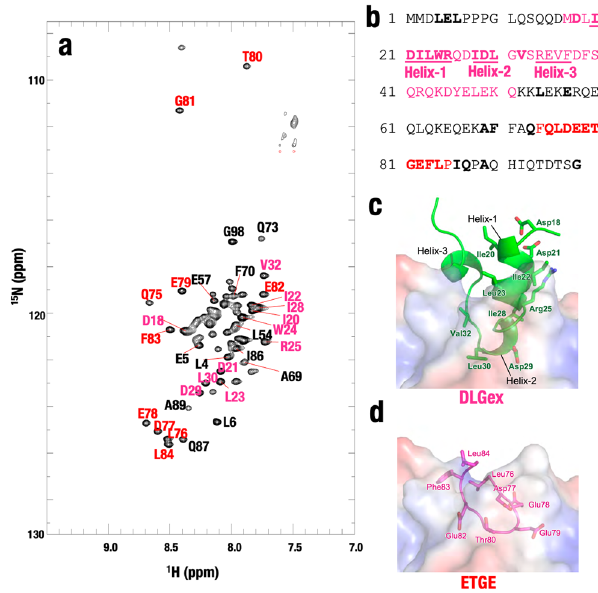
Fig. 2 Assignment of HN peaks of amino-acid main chain of labeled Neh2. a 2D TROSY-HSQC spectrum shows HN peaks of the main chain of amino acids of labeled Neh2 domain protein. b Alignment of mouse Neh2 domain. The assigned amino acids are in bold. The amino acids in Helix-1, Helix-2, and Helix-3 in the DLGex motif are underlined. c , d Structure of DLGex ( c ) and ETGE ( d ) motifs associating with the Keap1 pocket. Note that the DLGex motif possesses three-helix regions (Helix-1, 19 – 25; Helix-2, 28 – 30; Helix-3, 34 – 37) (PDB 3WN7, ref. 8 ), whereas the ETGE motif forms a β -hairpin structure (PDB 2DYH, ref. 16 ). We have proposed the two-site binding model in which each motif binds to a similar pocket structure in the Keap1-DC domain of the Keap1 homodimer (as shown in Fig.